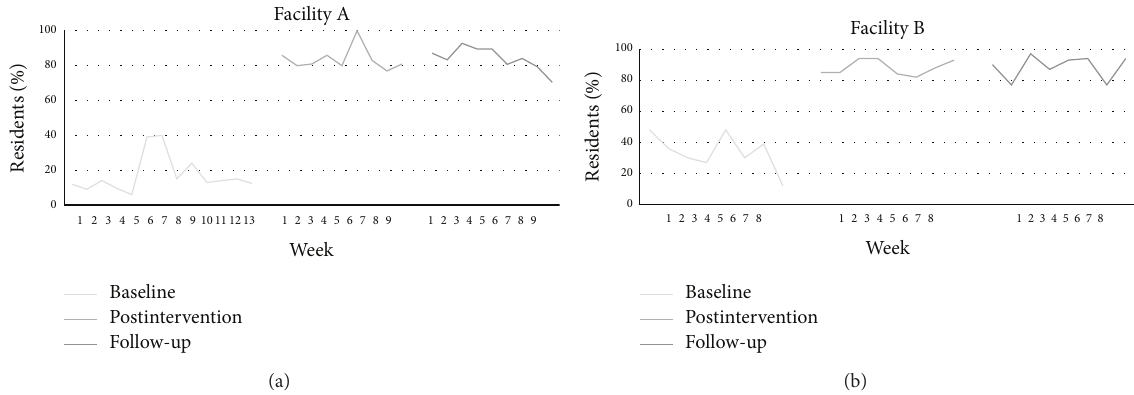
Figure 2: Percent of residents assessed each week with a standardized tool. Note . The percentages for Facility A are based on a total resident population of 𝑁 = 121–127 (resident population varied slightly from week to week). The percentages for Facility B are based on a total resident population of 𝑁 = 29–33 (resident population varied slightly from week to